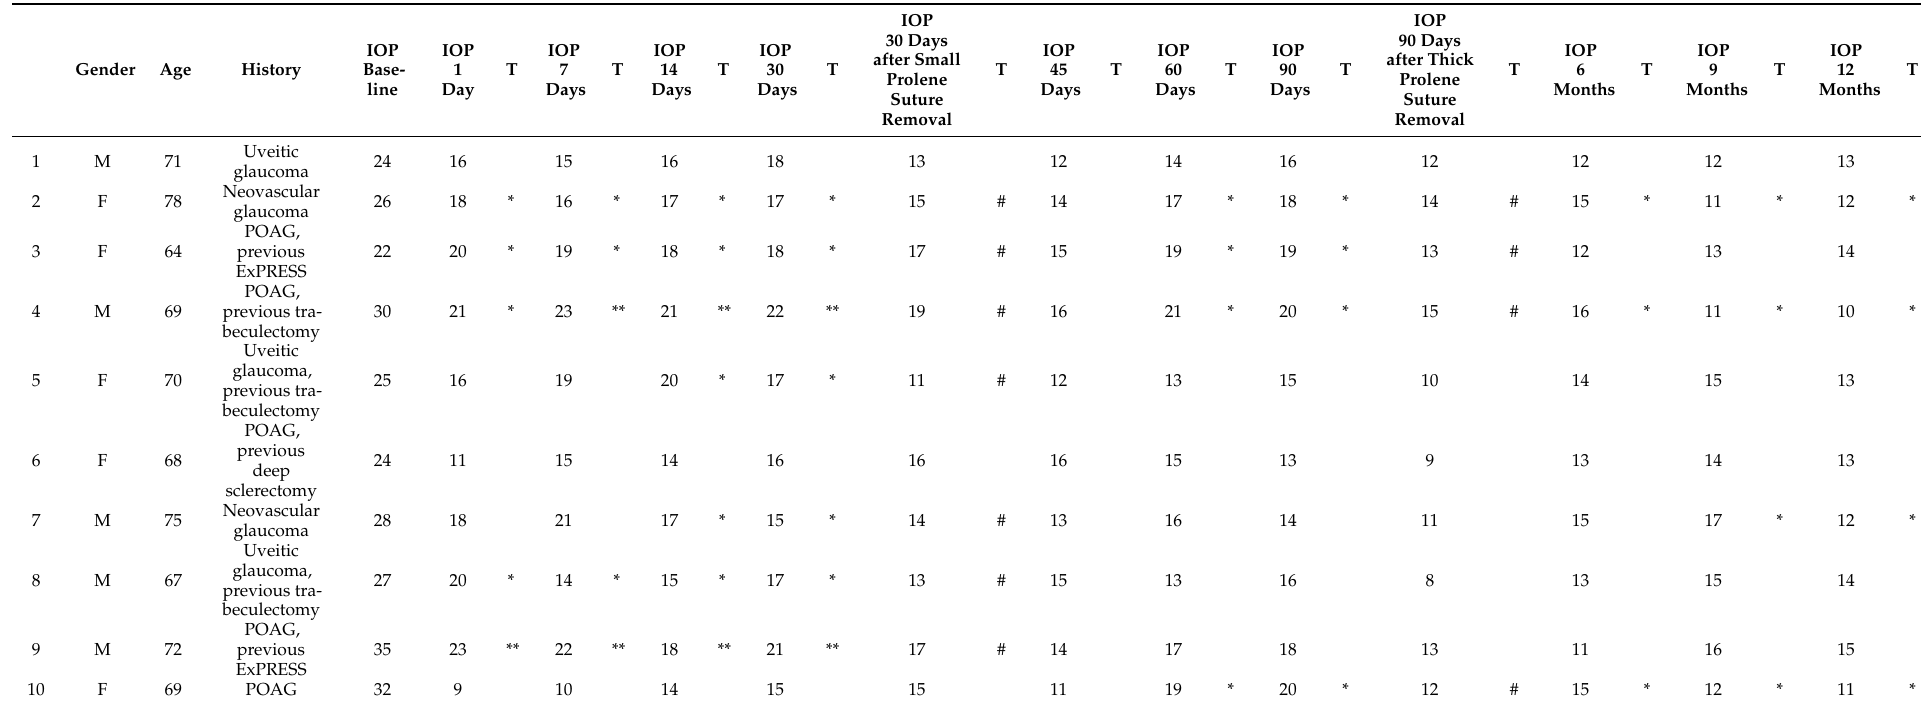
Table 1. Summary of gender, age preoperative IOP, and IOP value at each follow-up and if therapy was